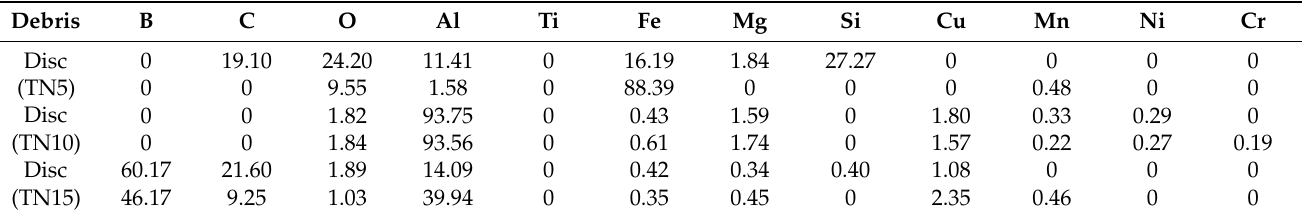
Figure 16. SEM micrographs of the surface of aluminum alloy discs worn against: ( a,b ) TN5; ( c,d ) TN10; ( e,f ) TN15. Table 5. EDS results of the debris on different aluminum alloy